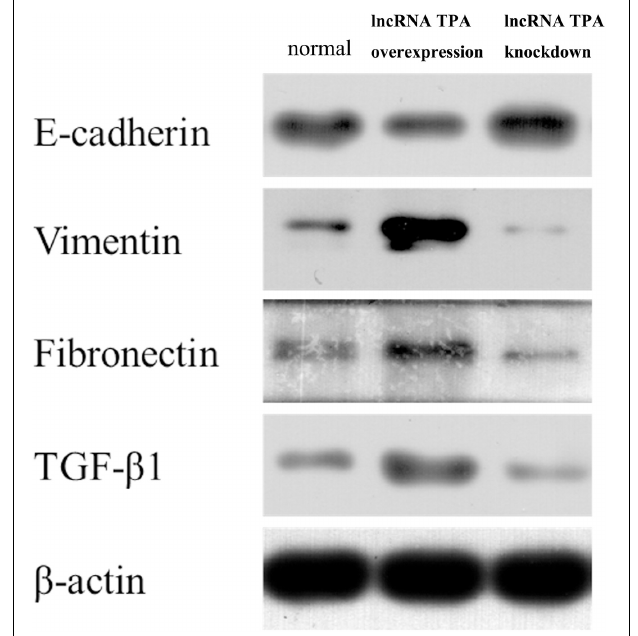
FIGURE 1 | The protein expression levels of E-cadherin, Vimentin, fibronectin, and TGF- β 1 in stably transfected breast cancer cell lines with lncRNA TPA overexpression and knockdown ( χ ± s, n =